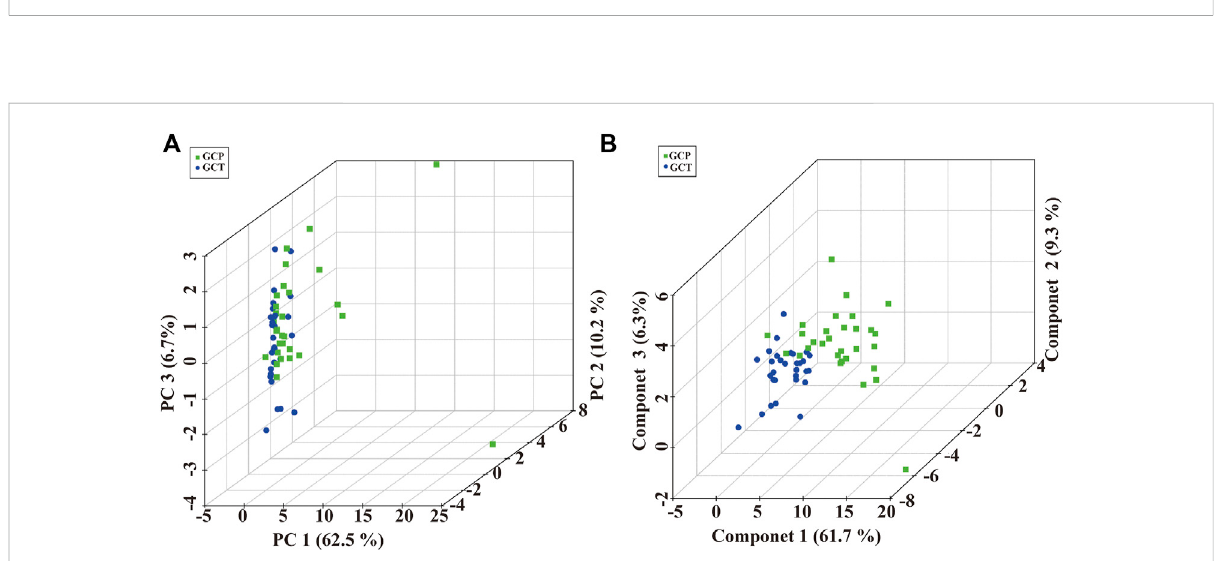
FIGURE 4 MultivariateanalysisofpseudotargetedmetabolomicsdataoftissuefromtheGCpatients. (A) Three-dimensionalscoreplotofthePCAmodels. (B) Score plots for the fi rst three latent components of the PLS-DA model. Cancer tissue in GC patients, GCT; adjacent tissue in GC patients,